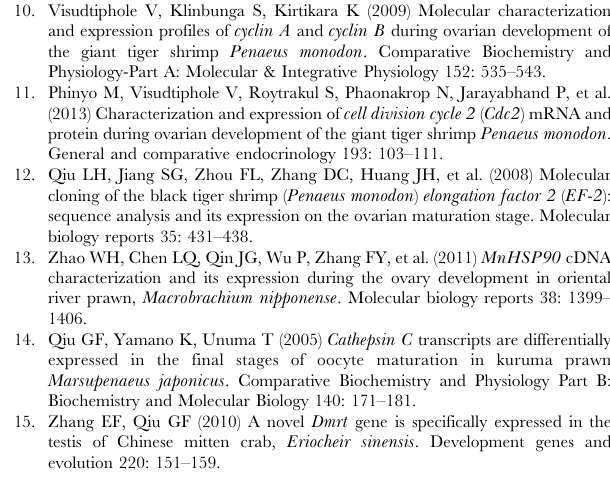
Figure S1 Alignment of the deduced amino acid se- quences of vasa . The amino acids conserved across all the eighteens species are shown in asterisks at the bottom. The GenBank accession numbers of the sequences are as follows: M.